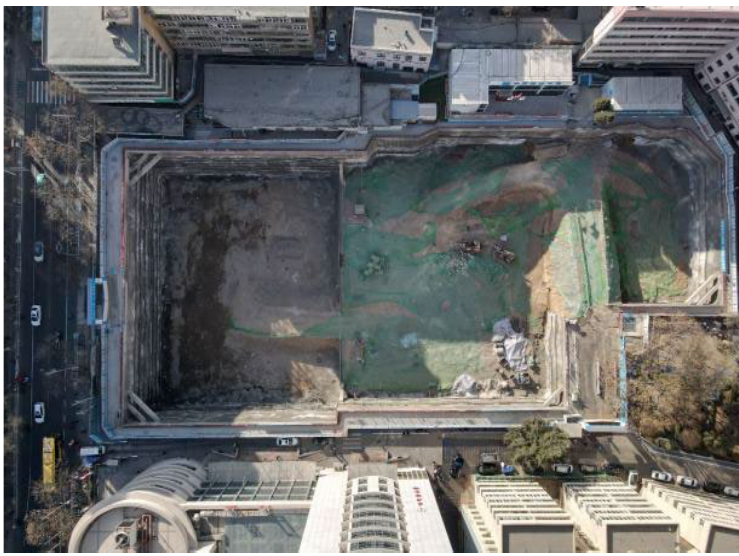
Figure 1. Map of the surrounding environment of the foundation pit.